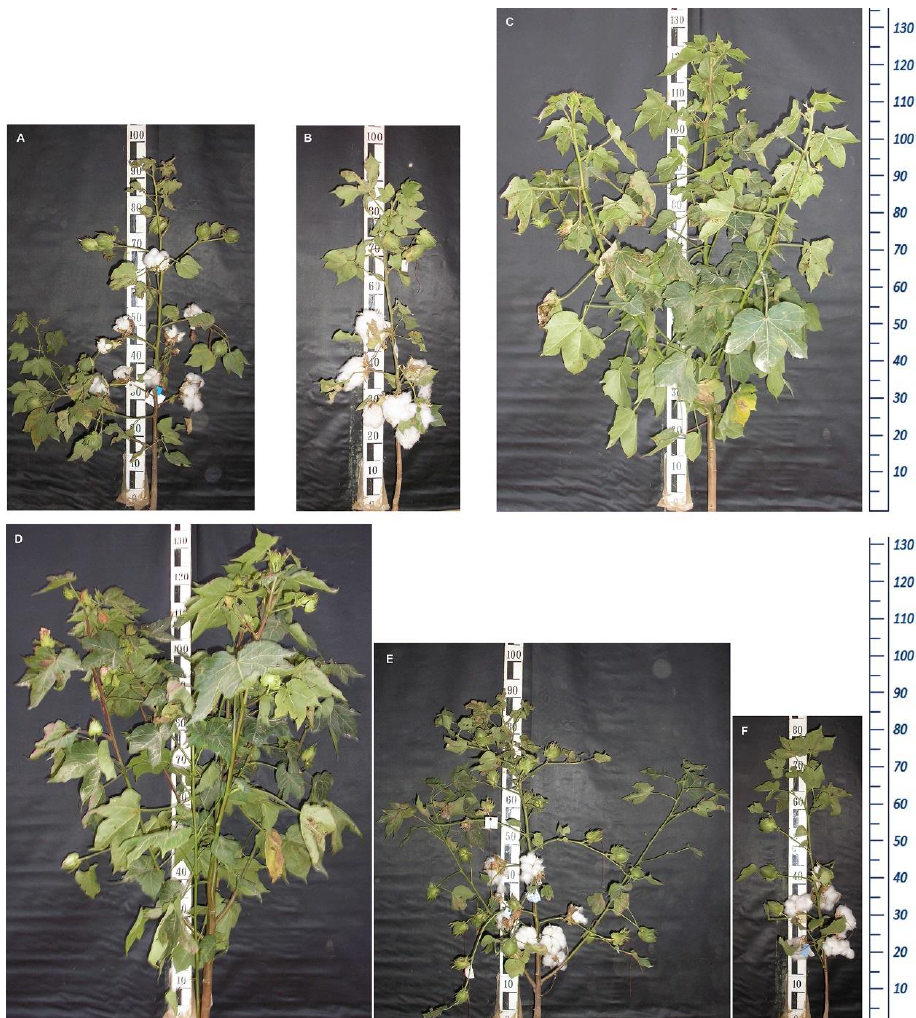
Figure 3. ( A – F ) — Cotton plant segregating genotypes of F 2 progeny. Broad-sense heritability ( H 2 ) ranged from 0.07 to 0.90% for all studied traits (Table 2). All photoperiod sensitivity-related traits, such as flowering time, number of branches, and height of sympodia were found to have high heritability (0.40 – 0.90). Table 2. Genetic variance and estimated broad-sense heritability ( H 2 ) of morphological and agro- nomical traits of the F 2 progeny, including their parental genotypes.